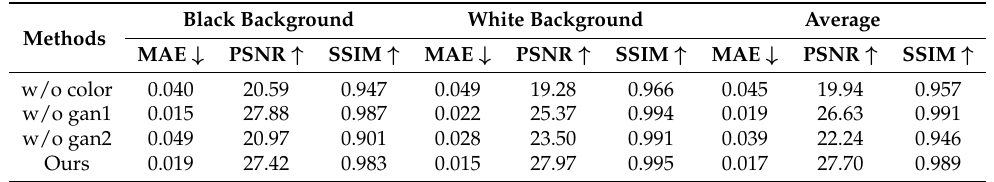
Table 3. Quantitative results of the ablation study on the cryosection dataset. ↑ denotes higher the better and ↓ represents lower the better.